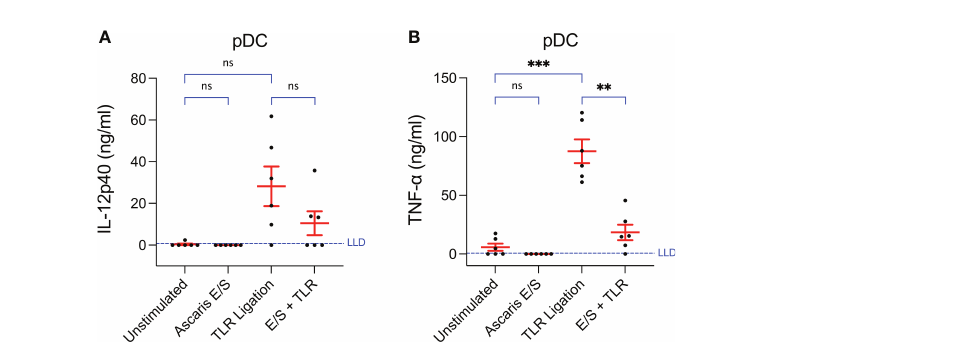
FIGURE 3 Production of TNF- a by pDC following TLR ligation is suppressed by the addition of Ascaris E/S. Concentrations of (A) IL-12p40 and (B) TNF- a measured by ELISA in the supernatants of pDC incubated at a density of 1x10 6 /ml for 24h. Cells were either unstimulated, or stimulated with Ascaris E/S, TLR ligands (100 ng/ml LPS, 500 ng/ml poly(I:C) and 300 ng/ml R848), or E/S and TLR ligands in combination. Supernatants were diluted 1:10 in cIMDM prior to IL-12p40 quanti fi cation and 1:20 prior to TNF- a quanti fi cation. Lower limits of detection (LLD) – IL-12p40: 0.781 ng/ml, TNF- a : 0.626 ng/ml. IL-4 and IL-10 were also measured but concentrations were undetectable after all treatments. Asterisks indicate statistical signi fi cance by paired t test with Bonferroni correction; **p ≤ 0.0033, ***p ≤ 0.00033. ns, not signi fi